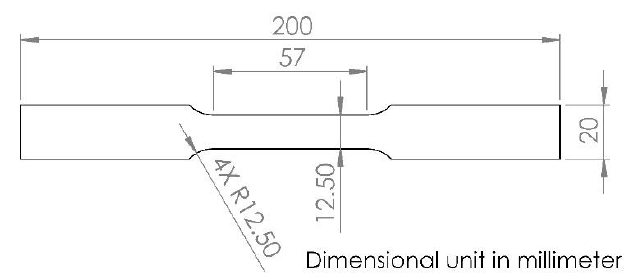
Figure 5. The dimension of the test workpiece in accordance with ASTM-E8.